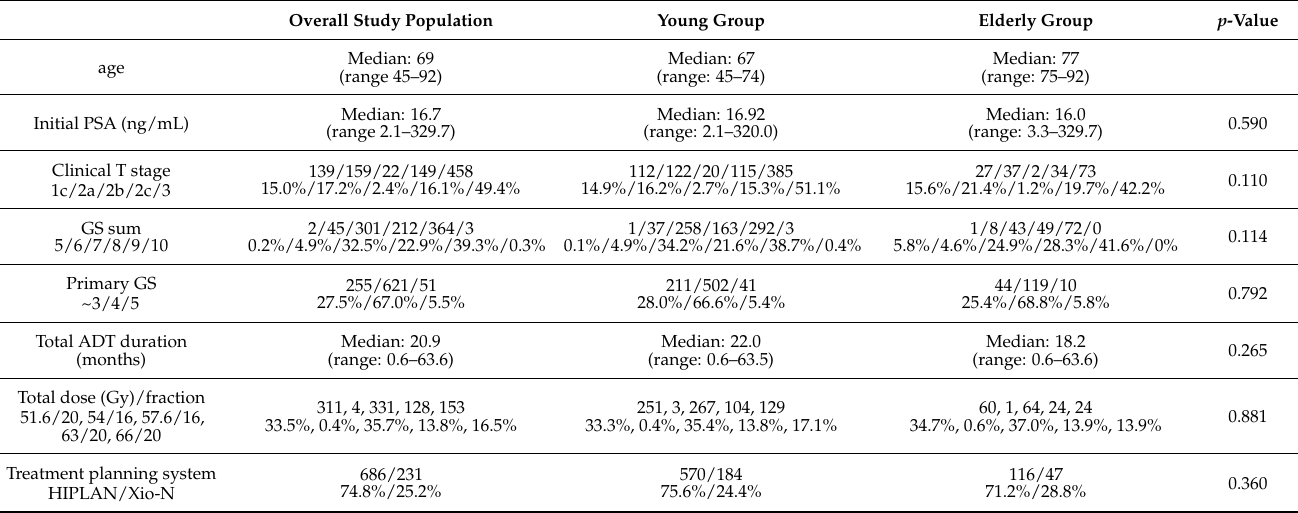
Table 1. Patient, tumor, and treatment